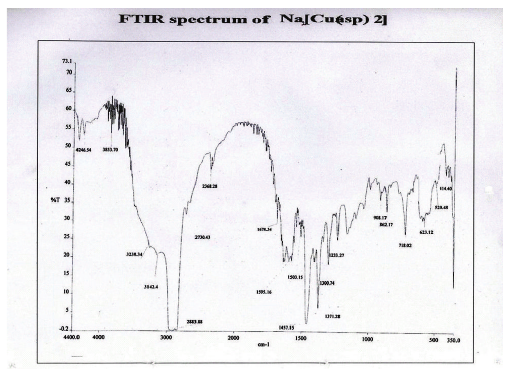
Figure 3: Infrared spectrum for Na 2 [Cu(asp) 2